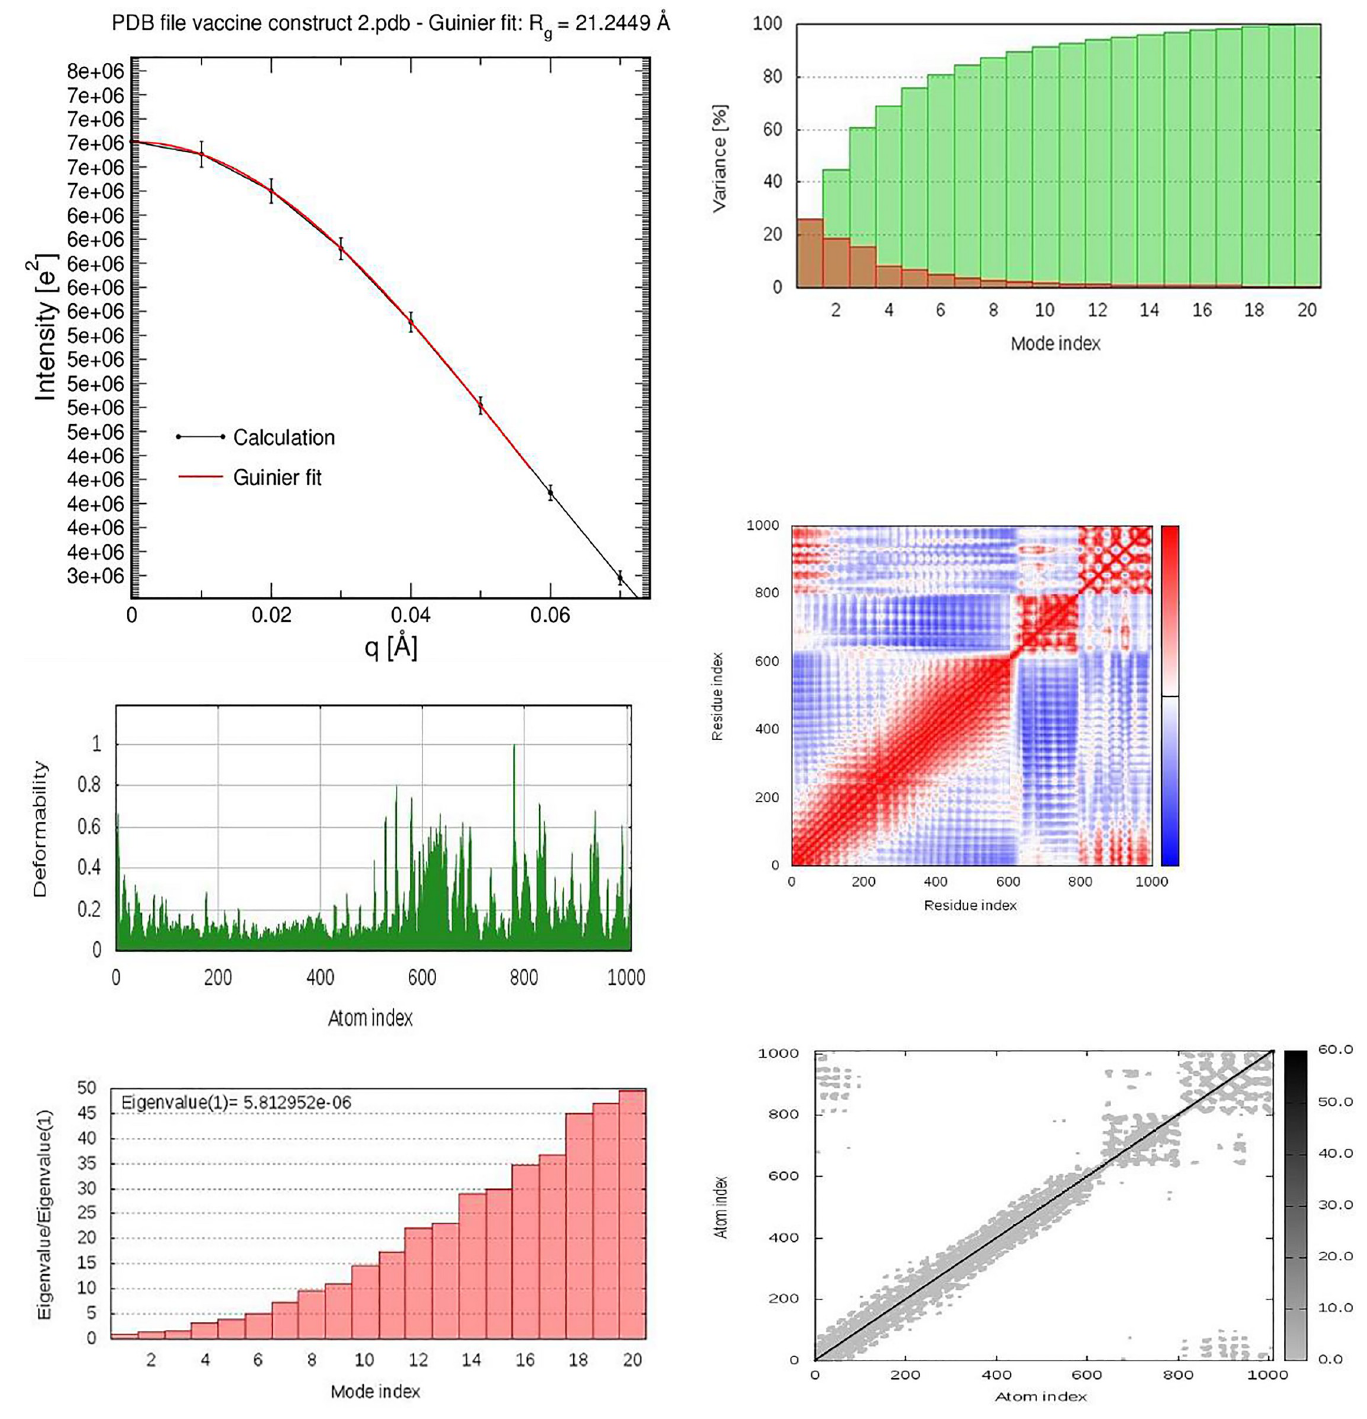
Fig 6. a: The radius of gyration of the peptide vaccine. (b-f) : Molecular dynamics simulation of the vaccine-TLR5 complex, showing ( b ) eigenvalue; ( c ) deformability; ( d ) B-factor; ( e ) Covariance matrix indicates coupling between pairs of residues (red), uncorrelated (white) or anti-correlated (blue) motions and ( f ) elastic network analysis which defines which pairs of atoms are connected by